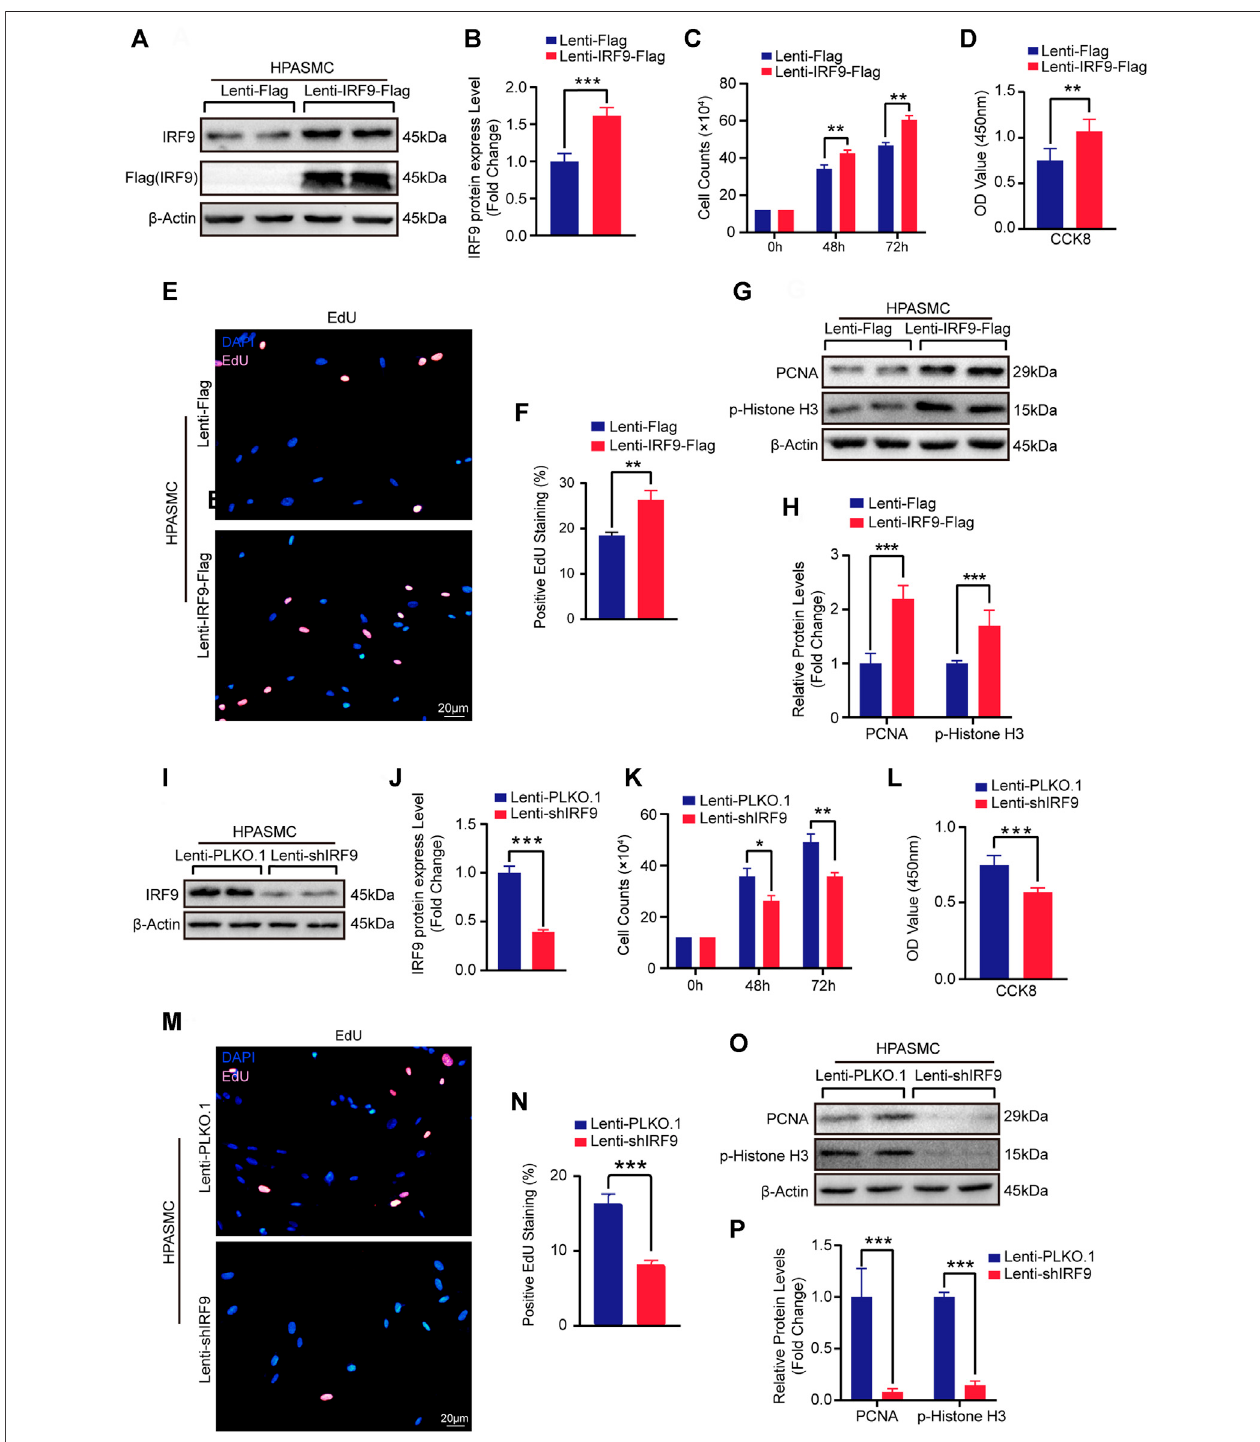
FIGURE4| Upregulation ofIRF9 accelerate and downregulationattenuate theproliferationofHPASMCs. (A,B,I and J) Theprotein level ofIRF9inHPASMCswith IRF9 overexpression (A) or knockdown (I) were detected by using western blot ( n (cid:2) 3 independent experiments); the IRF9 protein level was quanti fi ed (B,J) . (C,K) The counts of cell number after HPAMSCs treated with Lenti-IRF9-Flag (C) or Lenti-shIRF9 (K) for indicated time under normoxia condition; Lenti-Flag and Lenti-PLKO.1 serve as control group ( n (cid:2) 3 independent experiments). (D,L) CCK-8 assay shows the absorbances at 450 nm of Lenti-Flag/Lenti-PLKO.1 and Lenti-IRF9-Flag/ Lenti-shIRF9 HPASMCs under normoxia condition (n (cid:2) 3 independent experiments). (E,M) EdU incorporation assay of HPASMCs infected with Lenti-Flag/Lenti-IRF9- Flag (E) or Lenti-PLKO.1/Lenti-shIRF9 (M) under normoxia condition, in which nuclei were stained with DAPI (blue) and EdU merged with DAPI appears pink. Scale